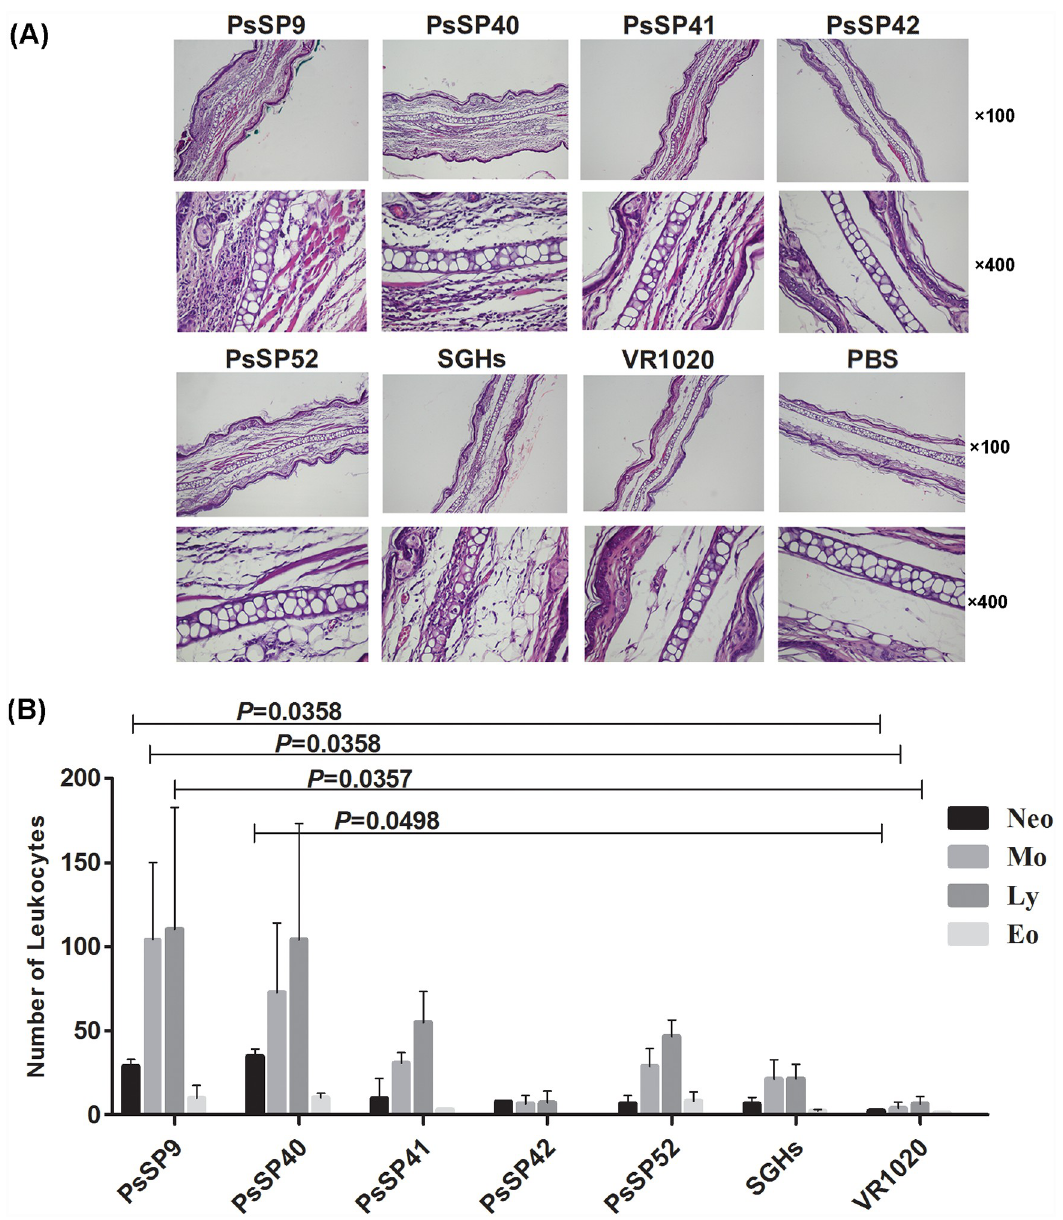
Fig 3. Histopathological analysis of the skin response to Ph . sergenti salivary proteins. Histological evaluation of representative ears of BALB/c mice immunized with PsSP9 , PsSP40 , PsSP41 , PsSP42 , PsSP 52, Ph . sergenti SGH, empty plasmid, or PBS. Two weeks after the last immunization, mice were challenged in the opposite ear with Ph . sergenti salivary gland homogenate. Ear sections stained with hematoxylin and eosin (H&E staining). Sections were analyzed by optical microscopy under 100 × and 400 × (A) or 100 × (B) magnification and the number of leukocytes enumerated microscopically. Bars represent the mean ± SD. Data are representative of two independent experiments (3–5 mice per group). The p value is indicated for each immunized group compared with the control plasmid group